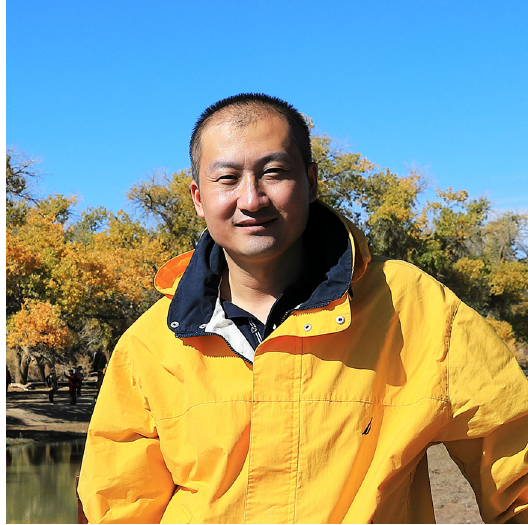
Figure 3. Dr. Yanhui